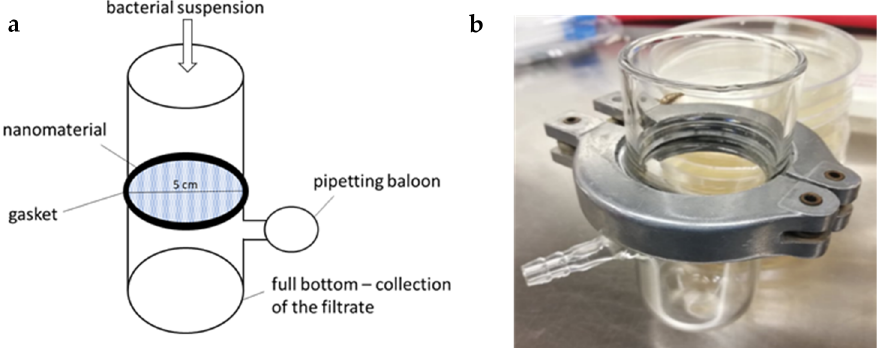
Figure 3. Filtration apparatus used for permeability assay; schema of the apparatus ( a ); photograph of the final device ( b ).